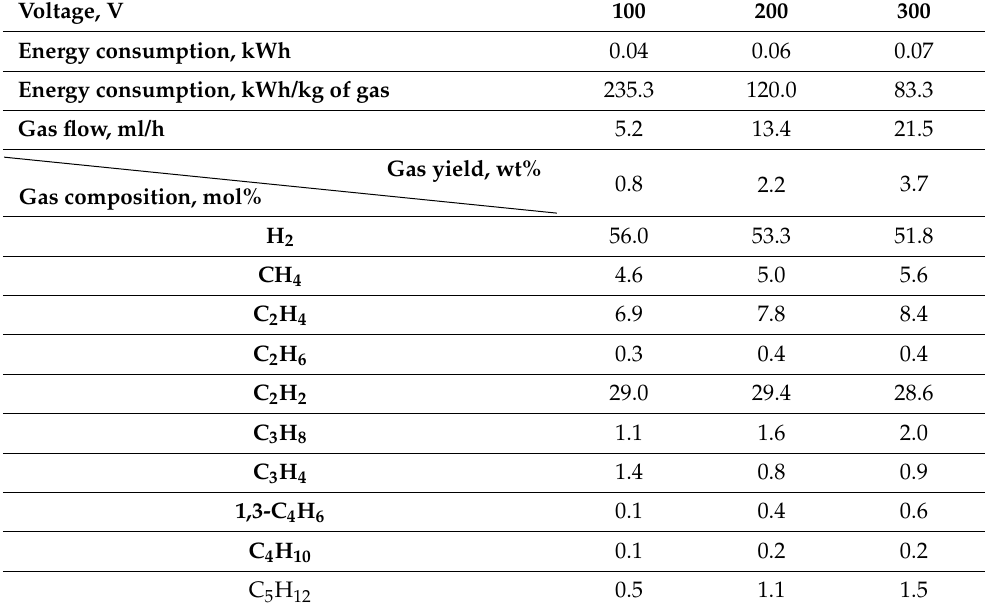
Table 3. Characteristics of the plasma pyrolysis of VGO and the composition of gaseous